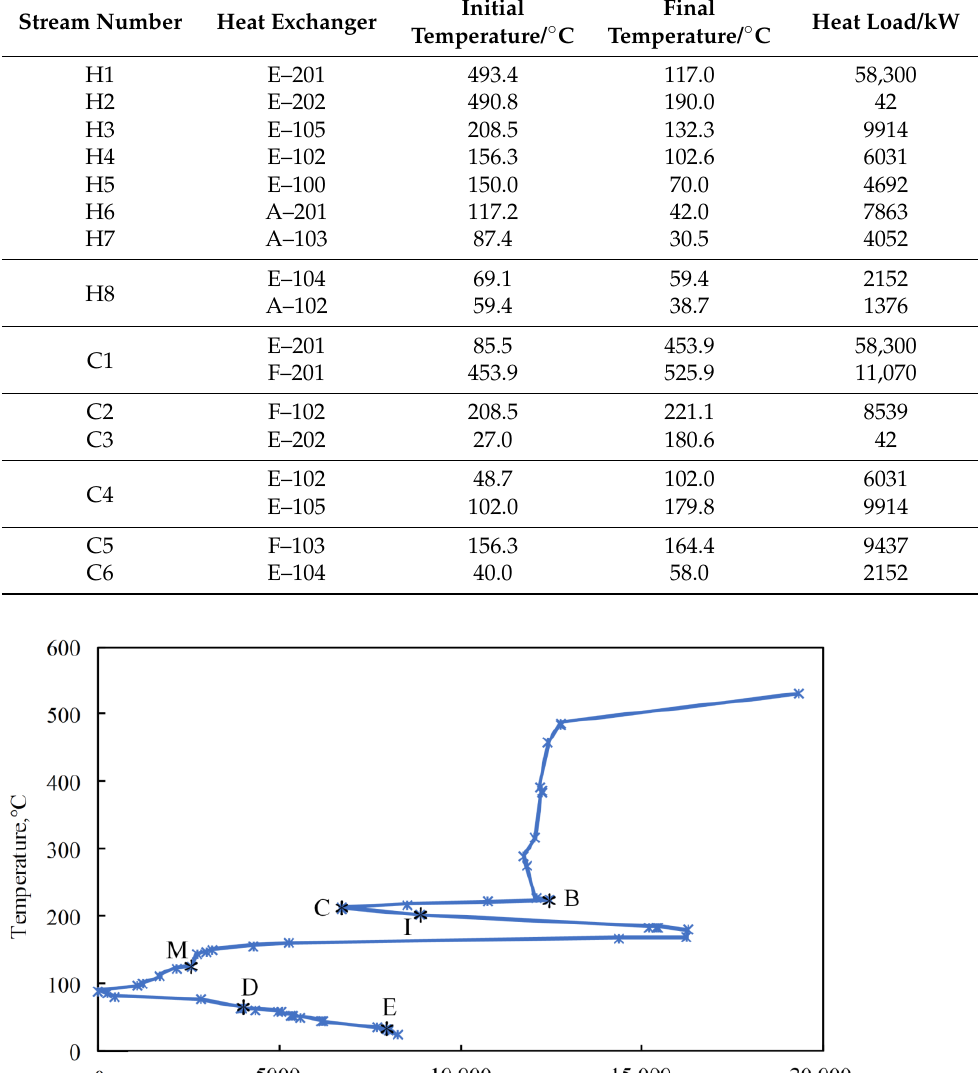
Figure 7. The pinch temperature is identified as 90.5 ◦ C (95.5 ◦ C for hot streams and 85.5 ◦ C for cold streams). The minimum consumptions of heat and cold utilities are 19,320.1 kW and 8255.4 kW, respectively. Table 4. Stream data of the heat exchanger network Table 4. Stream data of the heat exchanger network.